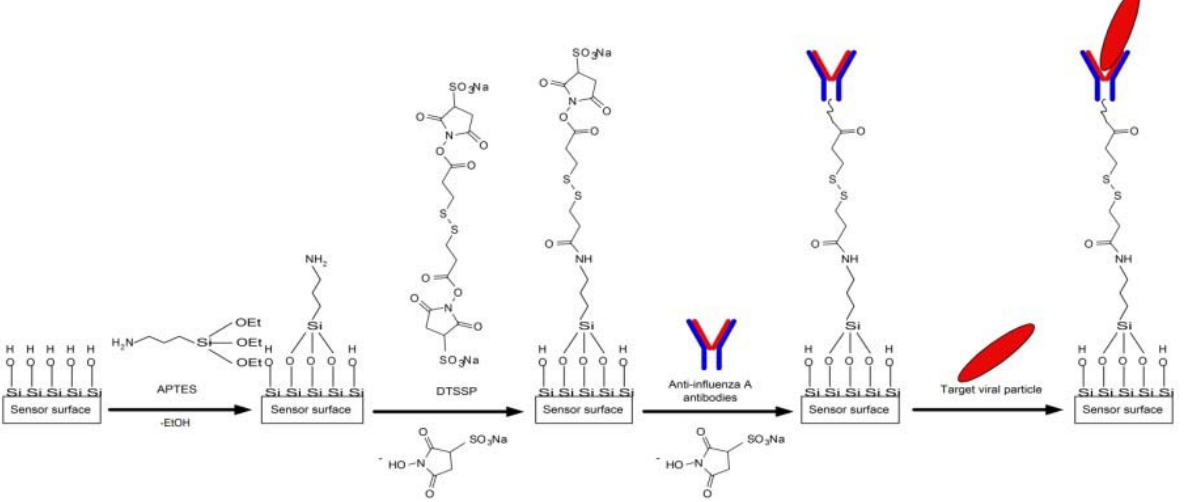
Figure 3. Schematic of the chemical modification of the sensor surface with APTES and its further sensitization with antibodies against the influenza A virus.